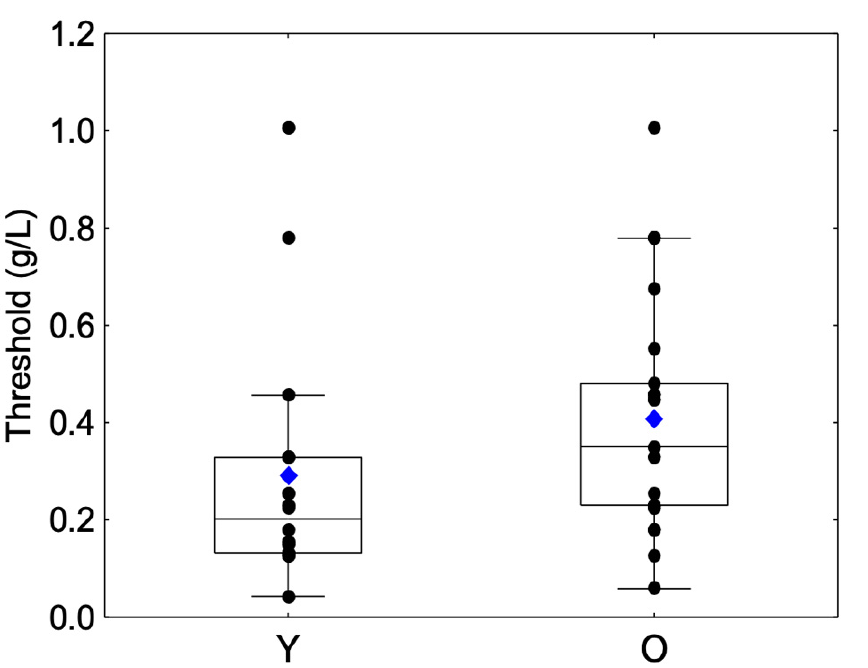
Figure 1. Box-plot distributions of threshold values as a function of the age category (young (Y) and elderly (O)) are shown. The bottom and top of the box correspond to the 25th and 75th percentiles, respectively. The horizontal band and the blue diamond correspond to the median and the mean, respectively. The ends of the whiskers represent nonoutlier ranges. The black dot symbols correspond to individual data points. Table 1. Characteristics of the young (Y) and elderly (O) panels.